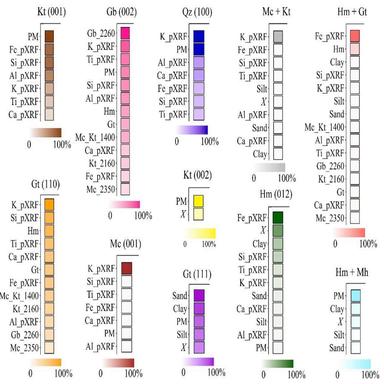
The importance of the variables for the best models for the minerals Kt (001); Kt (002); Gb (002); Hm (012); Gt (110); Gt (111); Hm + Mh; Hm + Gt; Mc (002); Mc + Kt and Qz (100), in decreasing order of importance for soils of Brazil. Kaolinite (Kt), muscovite (Mc), gibbsite (Gb), goethite (Gt), hematite (Hm), quartz (Qz).